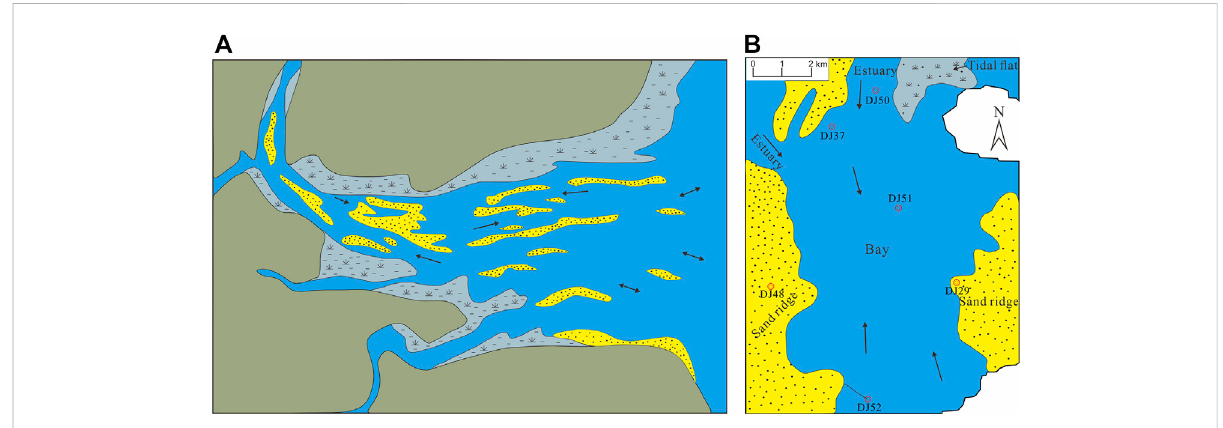
FIGURE 15 Comprehensivecomparison oftheestuarinesedimentary modelin theShan-2 Lower Sub-member intheeasternOrdos Basin. (A) Plane ofthe estuarine sedimentary model (according to M.O. Hayes, 1976; as quoted and modi fi edfrom Sun and Li, 1986). (B) Plane of theestuarine sedimentary model in the study